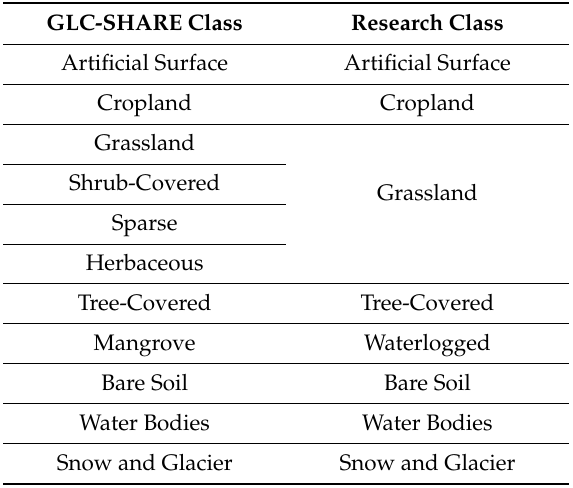
Table 1. Mapping of GLC-SHARE land use classes to Research